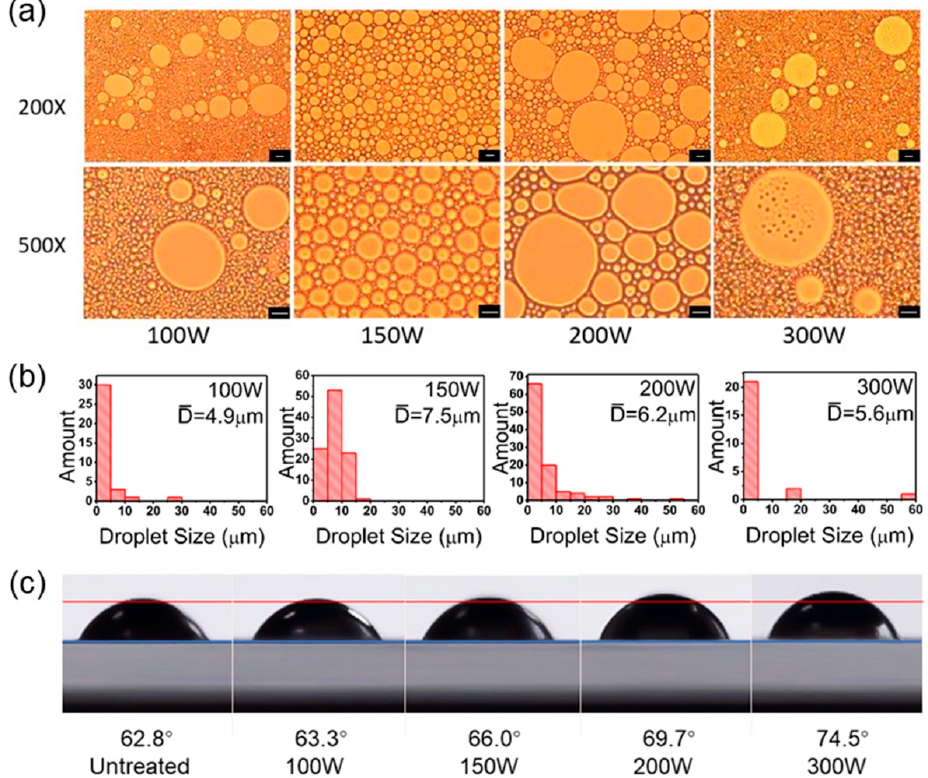
Figure 3. ( a ) Optical images of hexadecane / H 2 O Pickering emulsion stabilized by PS@PSS under di ff erent ultrasonic powers. Here the water:oil ratio is 1:1, salt concentration is 0.1 mM, and ultrasonic timeis3min. Thebaris10 µ m. ( b )Pickeringemulsiondropletsizedistributioninnumbercorresponding to microscope images. ( c ) Contact angle images of a water droplet on the glass plate coating with PS@PSS nanoparticles and contact angle data of PS@PSS after homogenizer treatment under di ff erent powers.